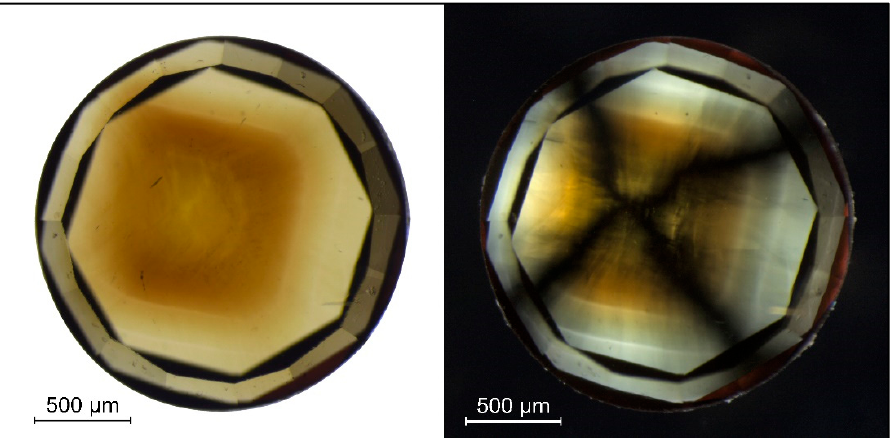
Figure 13. A mixed cuboid-octahedral growth hydrogen-rich diamond (TH 2.626), not colored by plastic-deformation-related defects. The obvious color zoning of the sample ( left ) is linked to the growth sectors, with the octahedral sectors being colorless and the cuboid sectors being light brown. The strain of this diamond ( center ) is clearly caused by the sector growth, hence strain between the brown cuboid and the colorless octahedral sectors. The light brown cuboid sectors are filled with tiny dust-like inclusions ( right ).